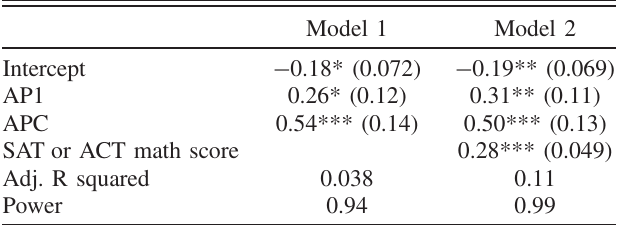
TABLE II. Regression model of FMCE scores on students ’ prior physics experience and students ’ SAT or ACT math